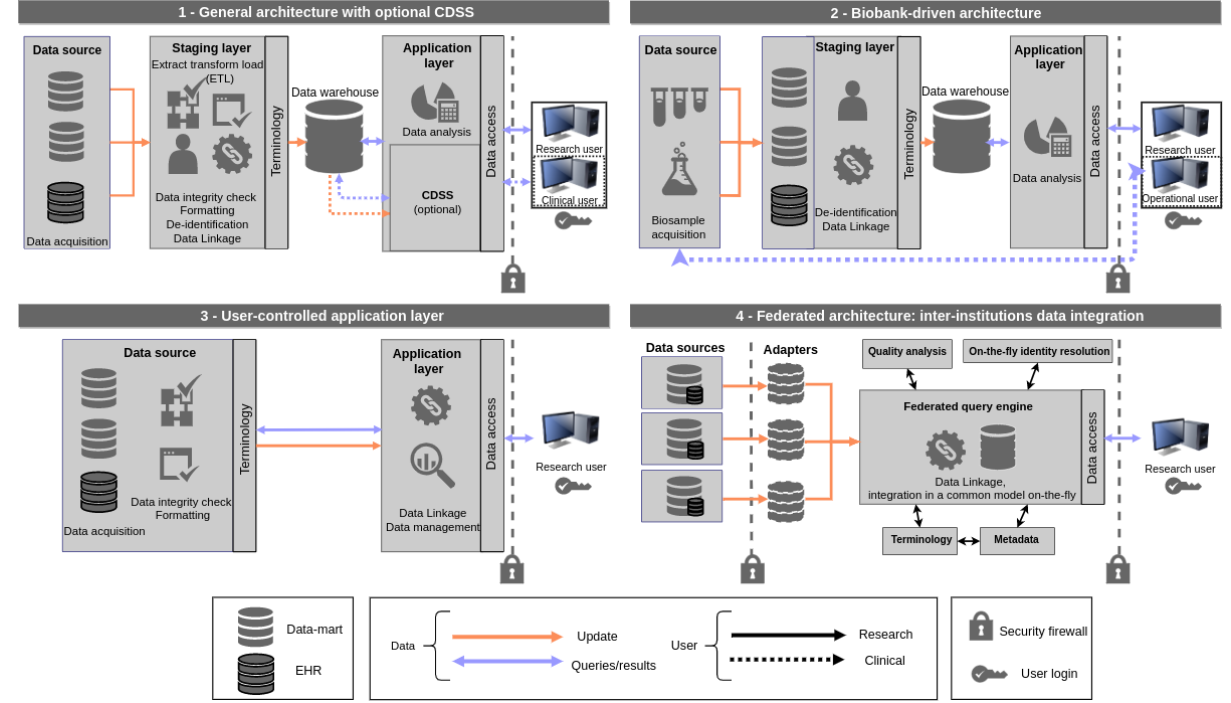
Figure 2. Architecture models identified from selected integrated data repositories (IDRs). Arrows indicate data output because of a query (blue) and data input (orange) because of data integration or update. Continuous lines show data query and integration applied by research users, whereas dashed lines are data queries performed by operational or clinical